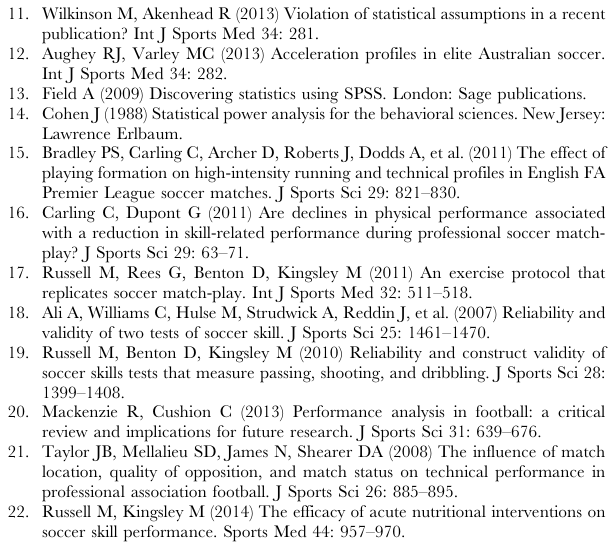
Table S3 Raw crossing data. Table S4 Raw dribbling data. Table S5 Raw time in play